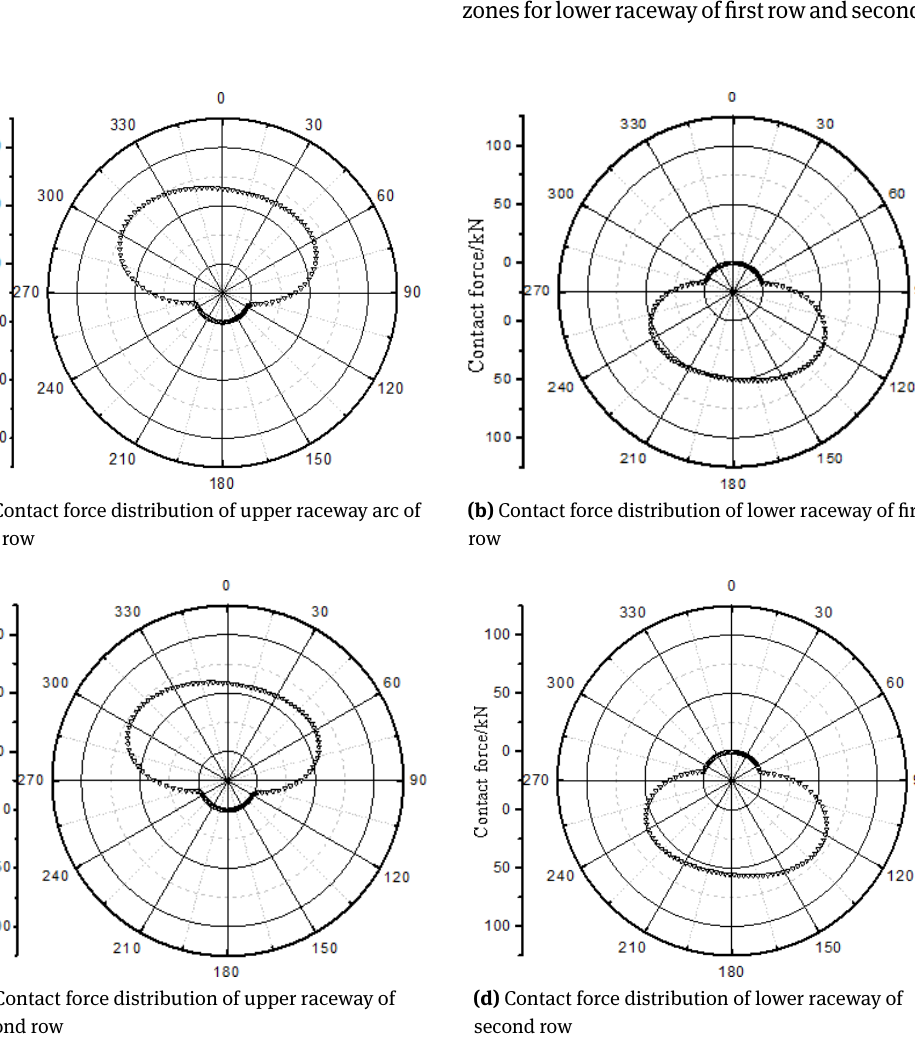
Figure 9: Contact force distribution in polar coordinates with flexible